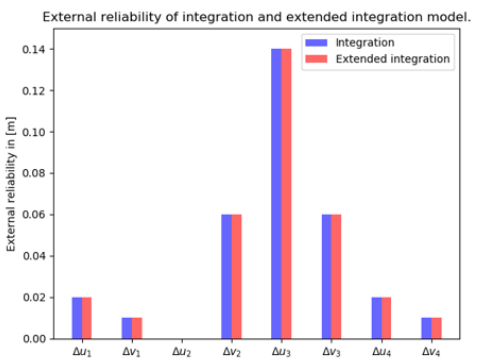
Figure 13. External reliability of vision measurements in the integration (in blue) and extended integration model (in red), with 8 satellites and 4 landmarks.